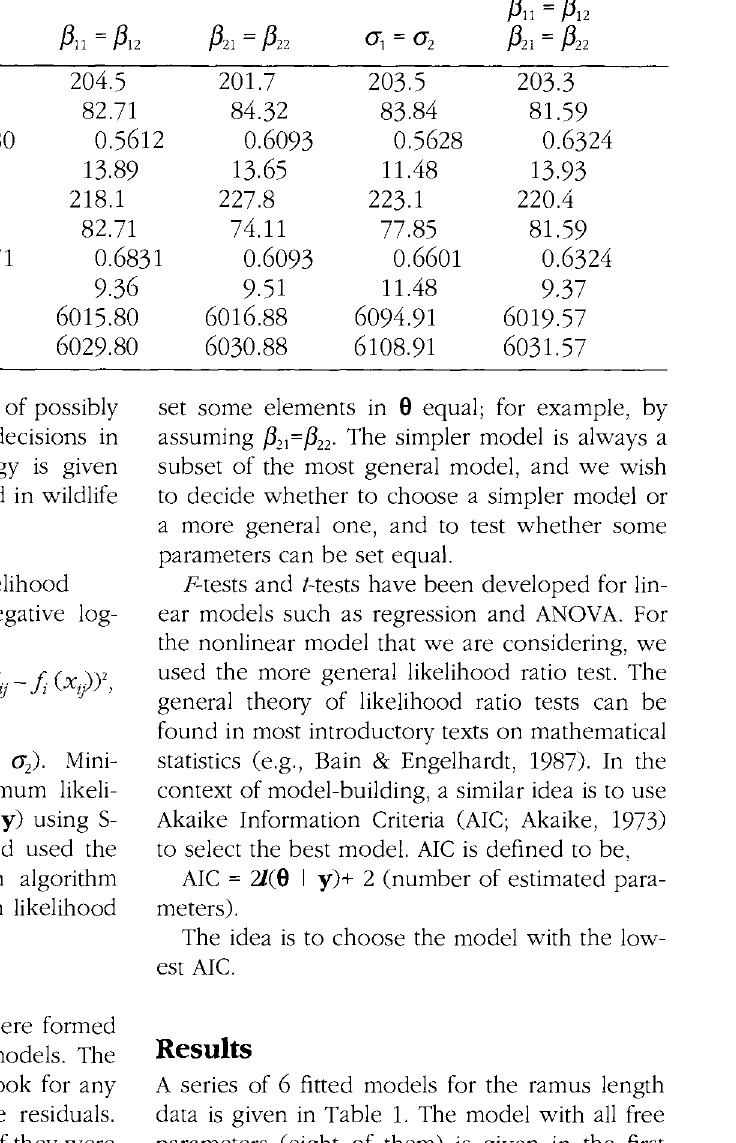
Table 1. Models and fitted values for parameters of growth curves of ramus length of Western Arctic Herd caribou. Models and fitted